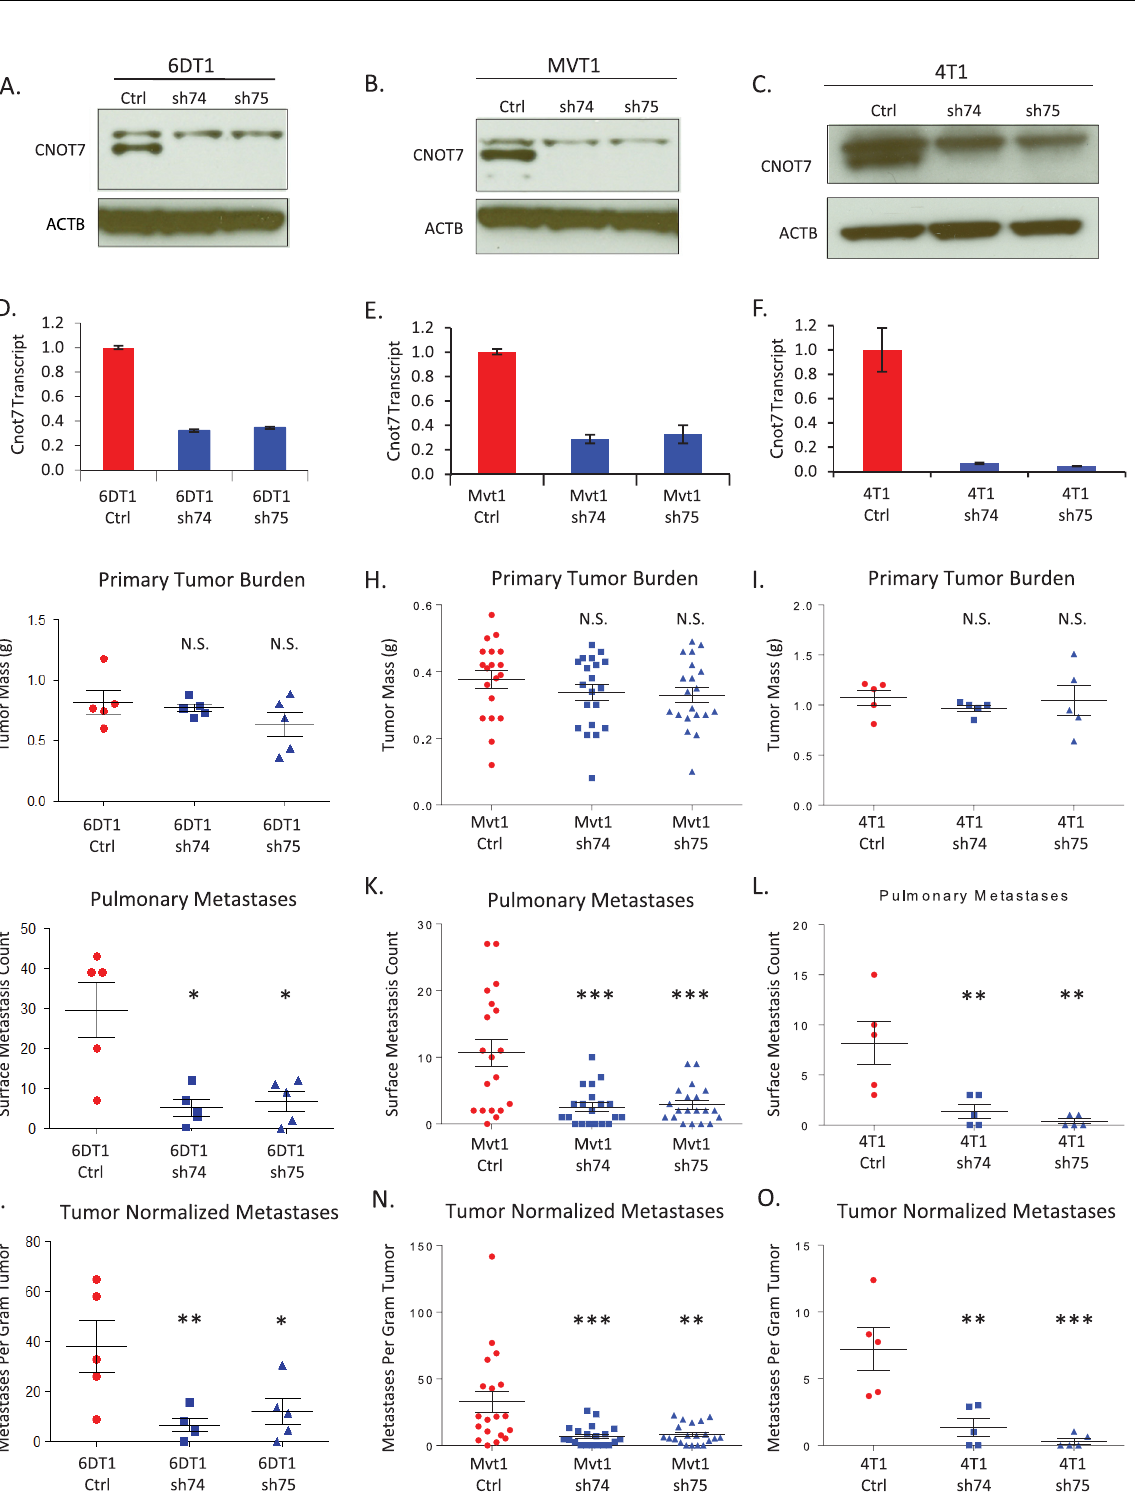
Fig 1. Results of Cnot7 knockdown experiments for the cell lines 6DT1, Mvt1, and 4T1. Characterization of shRNA knockdowns at the protein (A-C) and mRNA (D-F) levels are shown across the top of the figure. The upper band in the western blots is a non-specific band that appears with some batches of α - CNOT7 antibody. The mass of orthotopically implanted tumors at necropsy is displayed in panels G, H, and I. The number of macroscopic pulmonary surface metastases at necropsy for each cell line is presented in panels J, K, and L. The number of macroscopic pulmonary surface metastases after normalization for primary tumor burden is displayed in panels M, N, and O. N.S. = not significantly different. * = p < 0.05; ** = p < 0.01; *** = p <